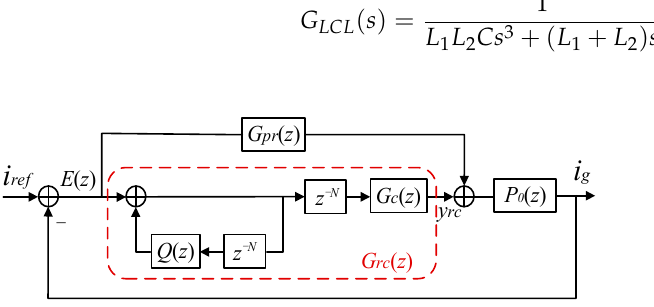
Figure 3. Control structure diagram of grid-connected LCL inverter in z domain.